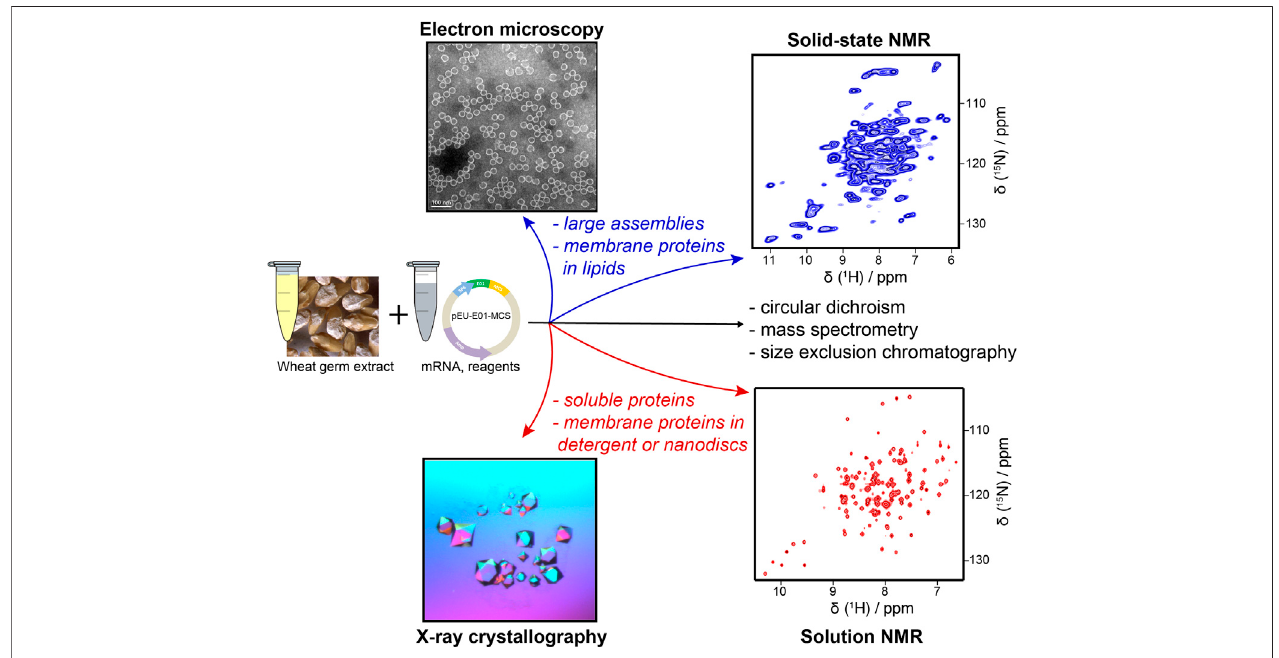
FIGURE 6 | Structural characterization of proteins produced from cell-free protein